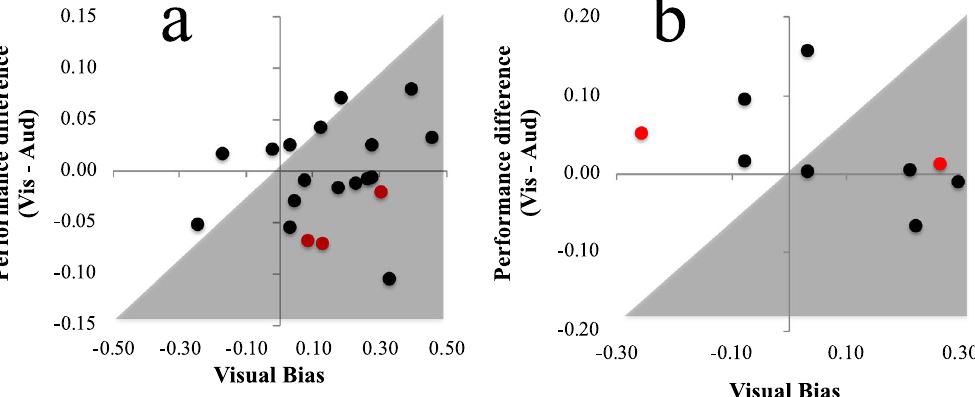
Figure 4. ( a ) X/Y scatterplot of individual visual bias scores (X axis) and proportional differences in correct performances on unimodal visual and audio trials (Y axis) from Experiment 1. Data points falling within the grey region are indicative of a greater visual bias than is justified by differences in unimodal trial performances. ( b ) Details are as for ( a ) but data are from Experiment